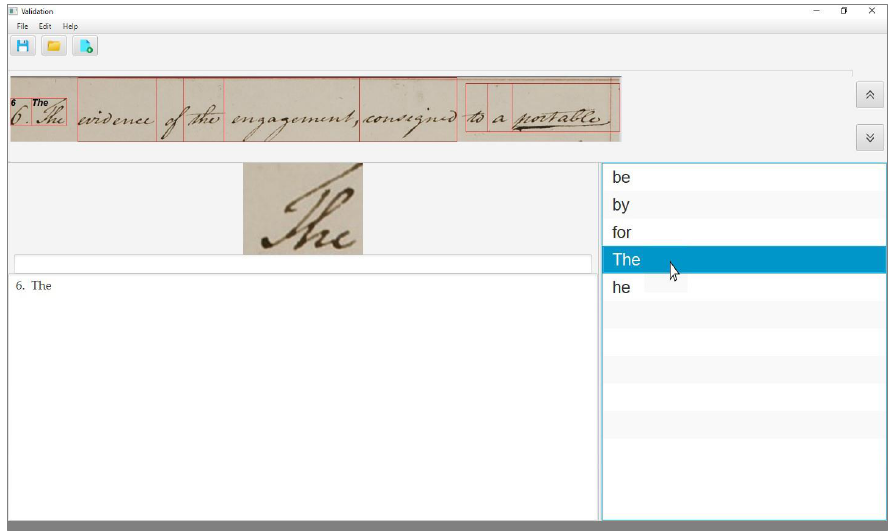
Figure 2. The user interface when transcribing a correct sample.